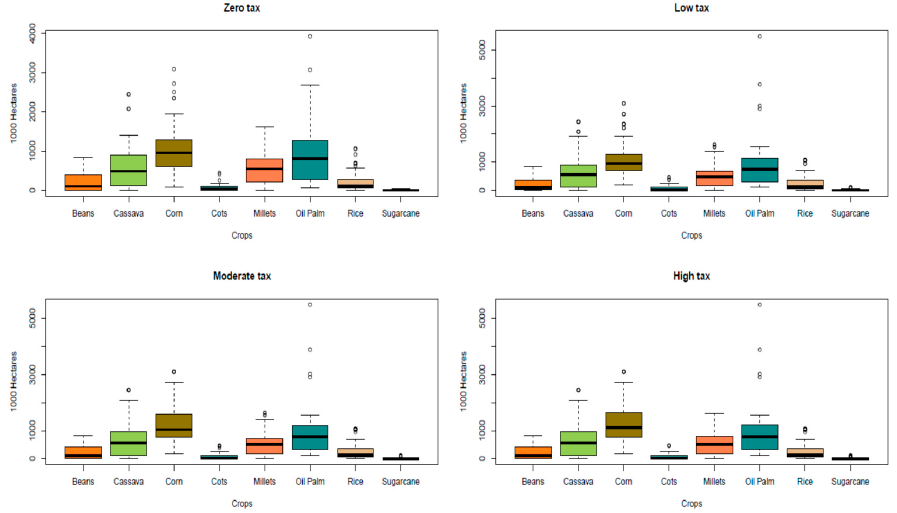
Figure 4. Agricultural crop area by 2050 under subsidy action.